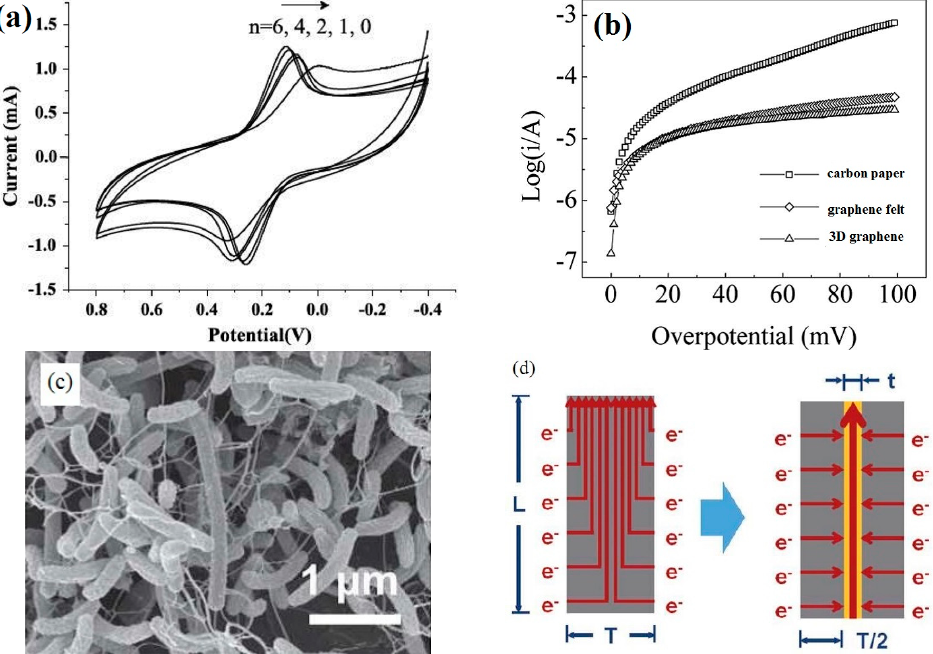
Figure 8. ( a ) Cyclic voltammograms of n-layer graphene composites (n = 0, 1, 2, 4, 6) in